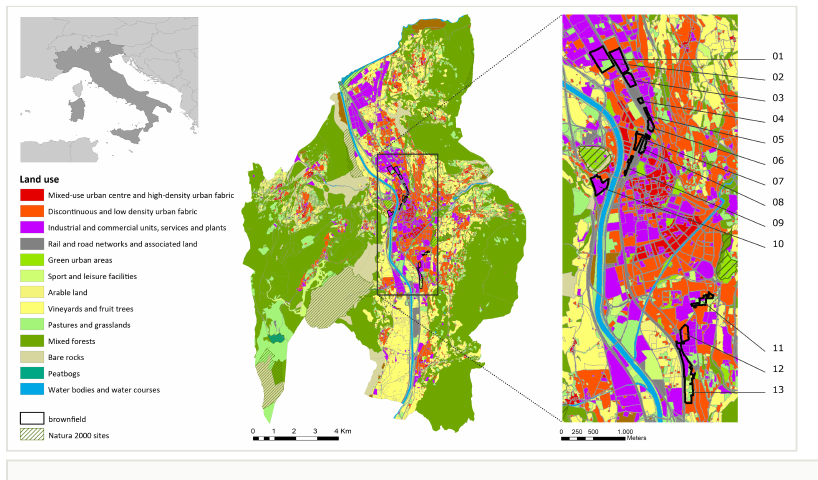
Main land uses in Trento, Natura 2000 sites and the 13 brown fi elds identi fi ed by the urban plan as ‘urban redevelopment sites’. Source: Comune di Trento